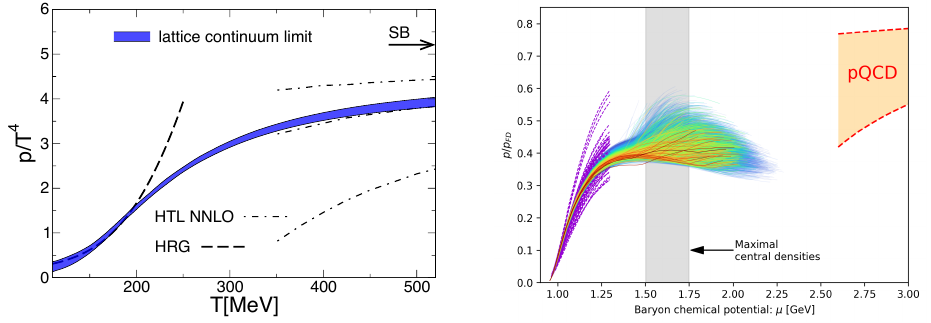
Figure 5. (Left) The equation of state of hot quark-gluon plasma (at zero baryon-number chemical po- tential) determined by lattice field theory and tested in ultrarelativistic heavy-ion collisions. The figure shows the pressure normalized by the free quark- and gluon gas. The lattice result is well reproduced by hadronic-resonance-gas model (HRG) at low temperatures and by perturbative (HTL NLO) calculation at su ffi ciently high temperatures. Figure from [33]. (Right) The analogous quantity at high baryon- number densities (zero temperature) — the pressure normalised by the the free-quark matter value. The colouring of the equations of state is based on their combined likelihoods; the lines terminate at fixed baryon-number density of n = 10 n s . At low densities, the equation of state is reproduced by hadronic models (purple dashed lines). At high chemical potentials, the equation of state approaches the pertur- bative one. At the chemical potentials reached in cores of massive neutron stars, the equation of state seems to reproduce the qualitative features expected for quark matter. Figure adapted from